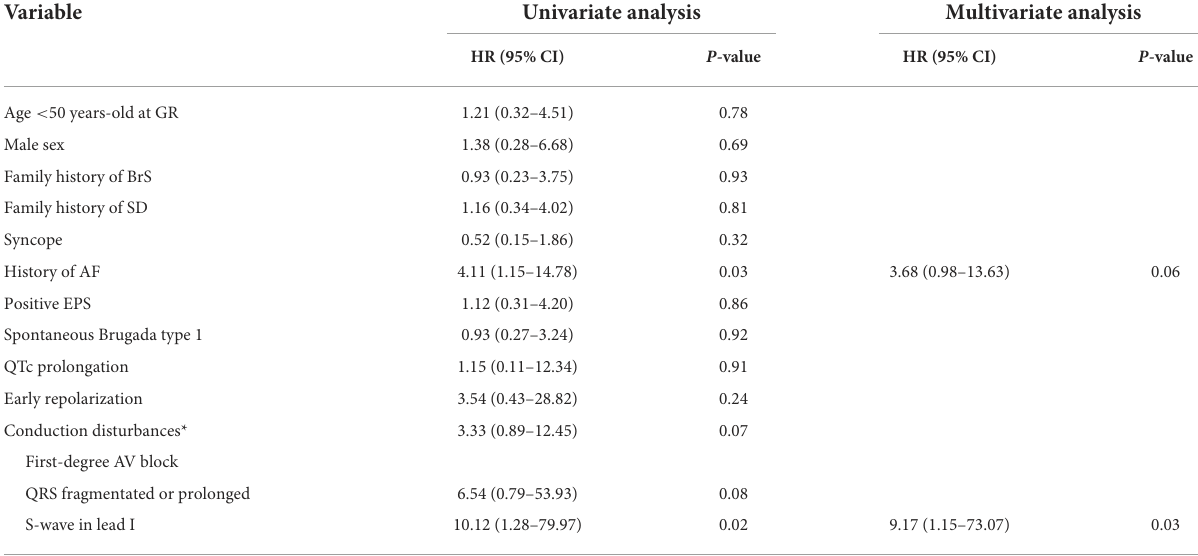
TABLE 3 Univariate and multivariate cox regression analysis for predictors of late appropriate ICD intervention.